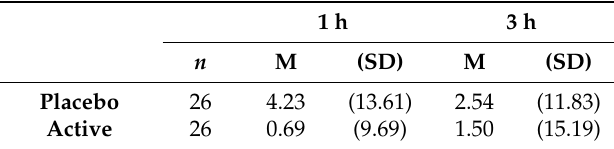
Table 4. Ratings on the “tranquil-troubled” item of the Bond–Lader mood scale, as the change from baseline, at both pre-stressor assessments after the dose for placebo and active treatments (Mean (M) and